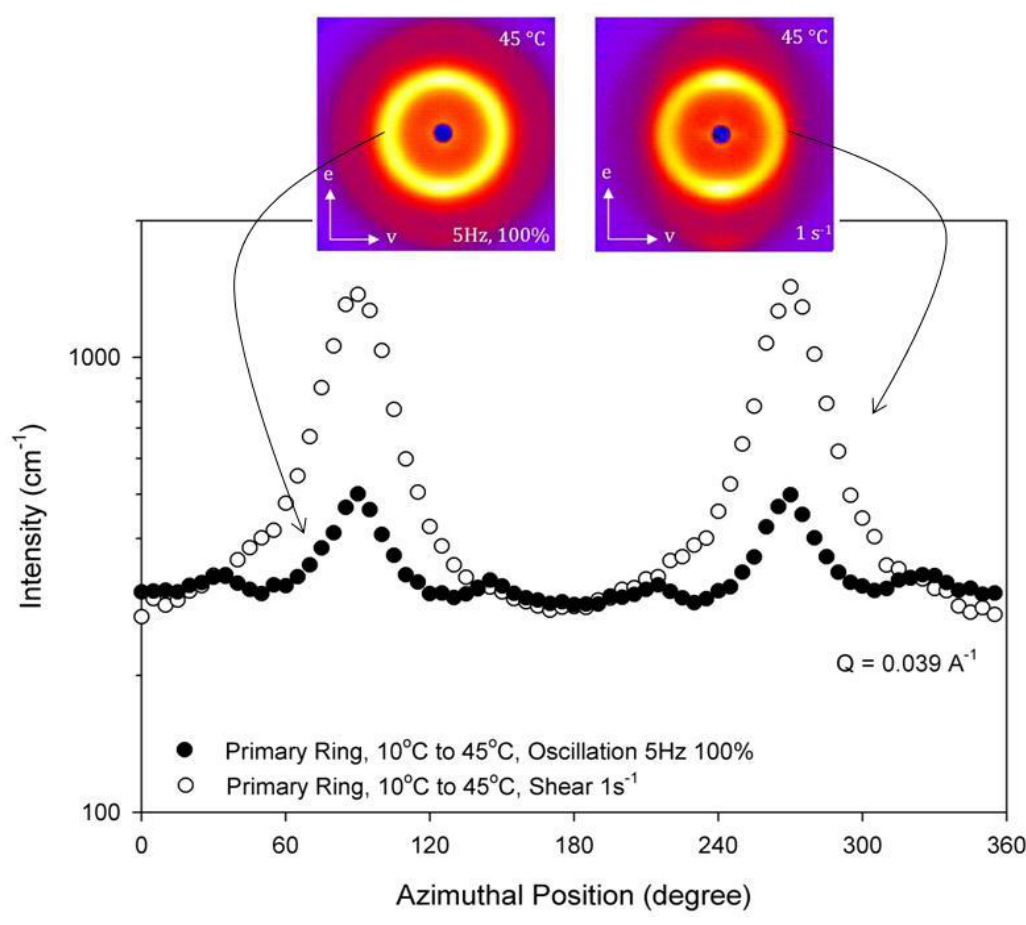
Figure 8. SANS scattering profiles for 35 wt% block copolymer at quenched from 10 °C to 45 °C under oscillation (5 Hz and 100% strain) and under shear (1 s −1 ). The intensity as a function of azimuthal angle in the primary ring is shown in closed symbols and under shear (1 s −1 ) in the plot. The 2D SANS patterns shown at the top demonstrates the azimuthal dependence being